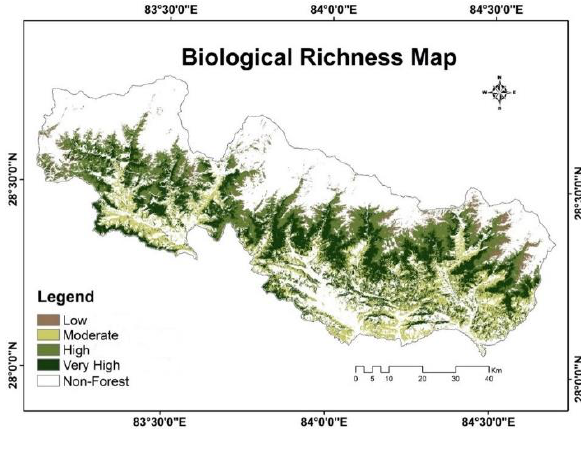
Figure 6. Biological richness map of study